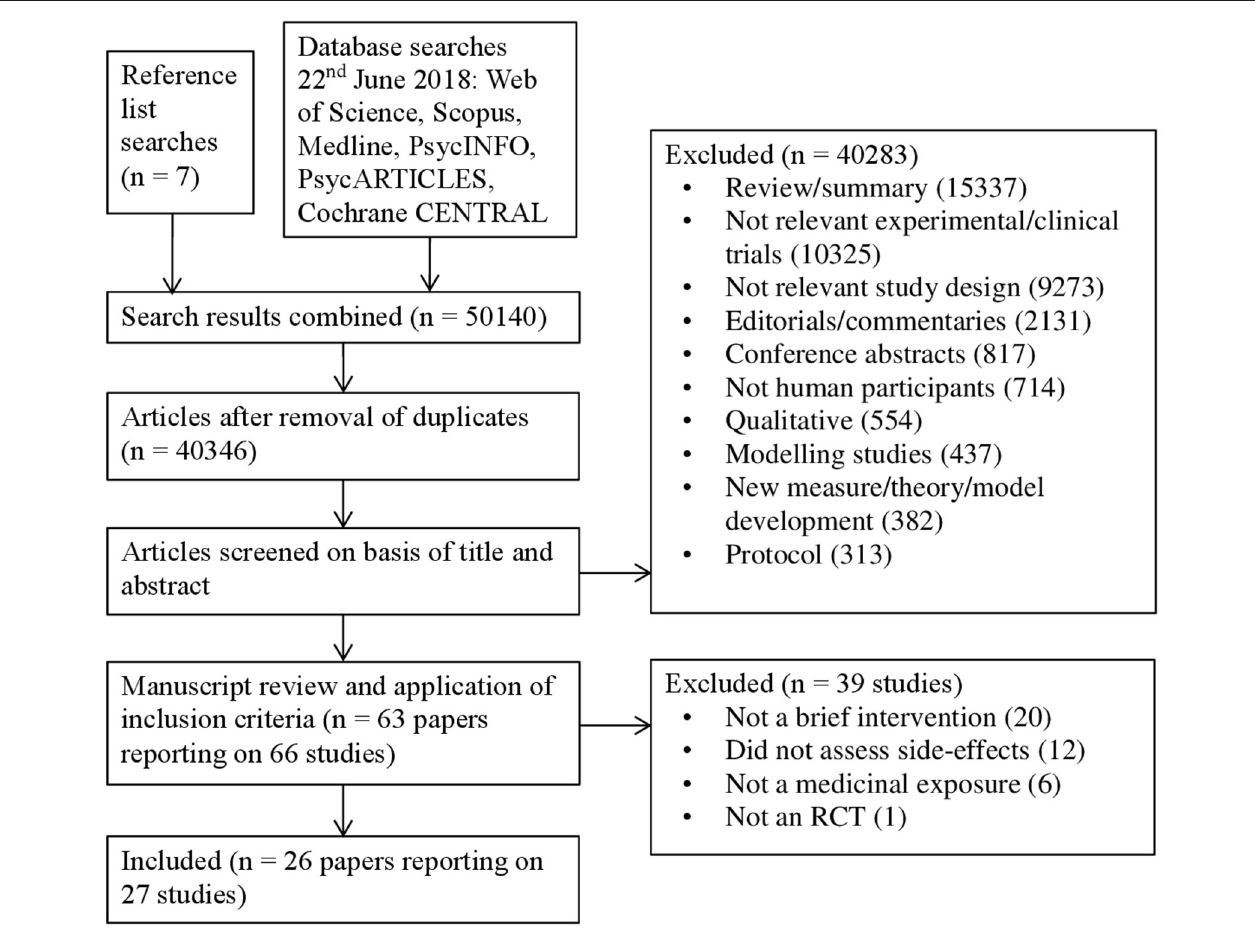
FIGURE 1 | Flow diagram of the selection process of studies including the number of events and reasons for